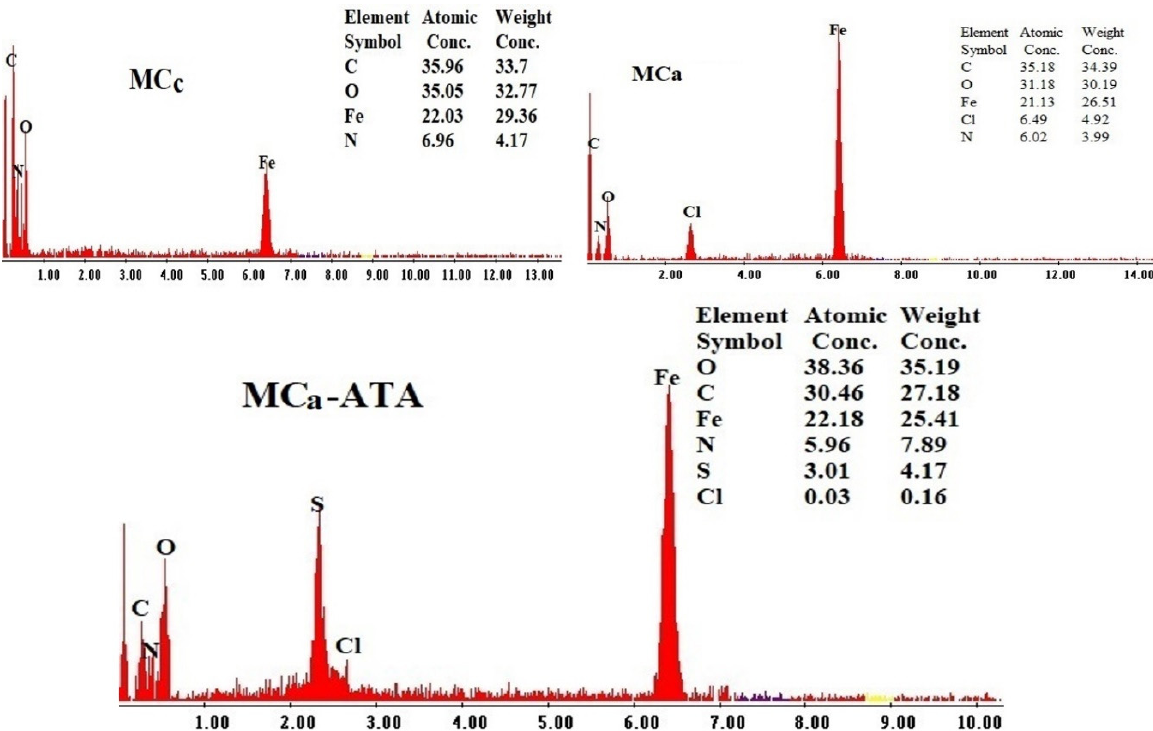
Figure 2. EDX data of the sorbent and after modification (MCc, Mca, and MCa-ATA) .